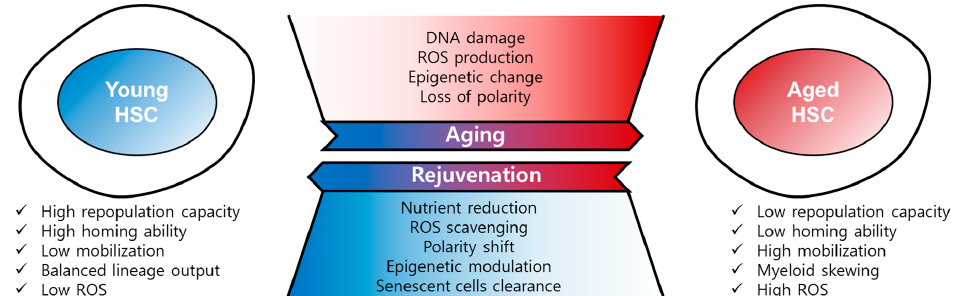
Figure 2. Regulation of HSC aging and rejuvenation. Aged HSCs have the hallmarks of low repopulation capacity, low homing ability, high mobility, myeloid skewing, and high ROS, among others. HSC aging is driven by DNA damage, ROS, epigenetic change, and loss of polarity. Aged HSCs can be rejuvenated by nutrient reduction, ROS scavenging, polarity shift, epigenetic modulation, and senescent cells clearance.